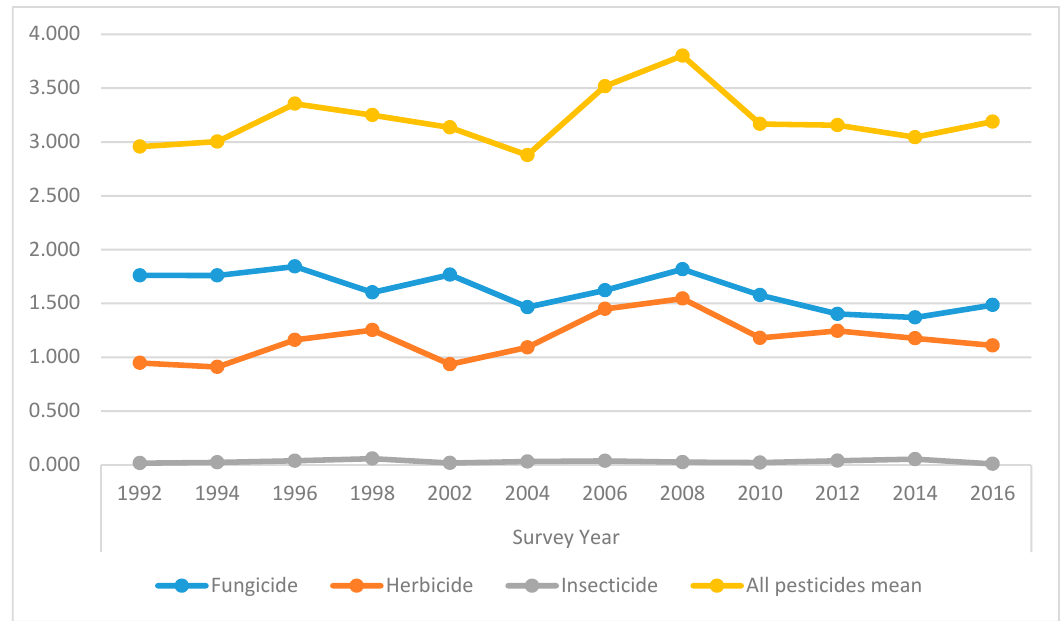
Figure 7. Application intensity (kg/ha) of the major pesticide groups to arable crops in Northern.